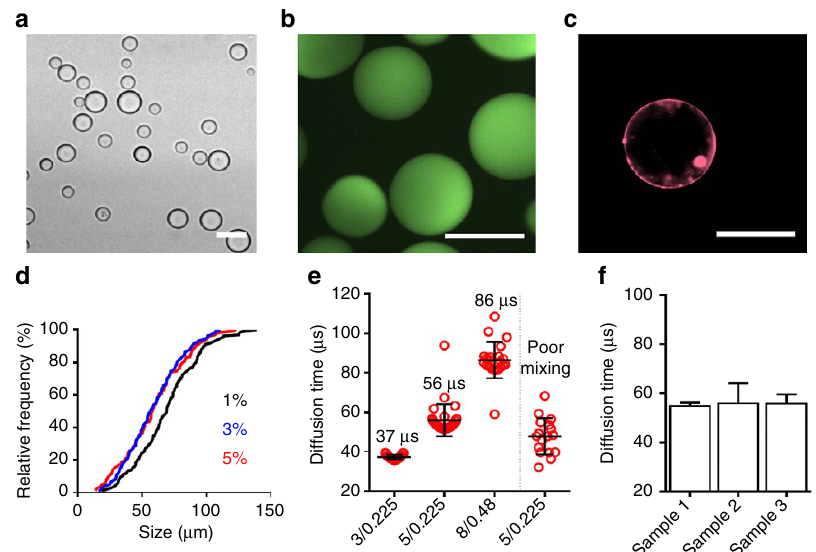
Figure 1 | Characterization of polyacrylamide (PAA) beads. ( a ) Bright-field image of polymerized PAA beads after filtration. Scale bar, 50 m m. ( b ) Fluorescence image of PAA microbeads containing trapped large polymers functionalized with FITC; scale bar, 50 m m. ( c ) Fluorescence image of coating of PAA beads with Cy3-Fibronectin; scale bar, 50 m m. ( d ) Distribution of size of polyacrylamide beads in dependance on the concentration of PFPE-PEG surfactant (1, 3 and 5%) during initial vortexing. ( e ) Characteristic diffusion time of SRB molecules, using FCS, within gels indicated uniformity of beads (small dispearsion) and mechanical properties. Small time of diffusion is characteristic for soft gels and increases with the volume fraction. Gels are defined by the acrylamide/bisacrylamide ratio. On the right, for 5/0.225 gels we show the effect of mixing on the uniformity of the batch. Each point corresponds to a single mesure of the diffusion time within the bead. ( f ) Uniformity and reproducibility is maintained between batches (sample 1, sample 2 and sample 3) of the same acrylamide/bisacrylamide ratio (5/0.225). ( e , f ) Mean ± s.d.